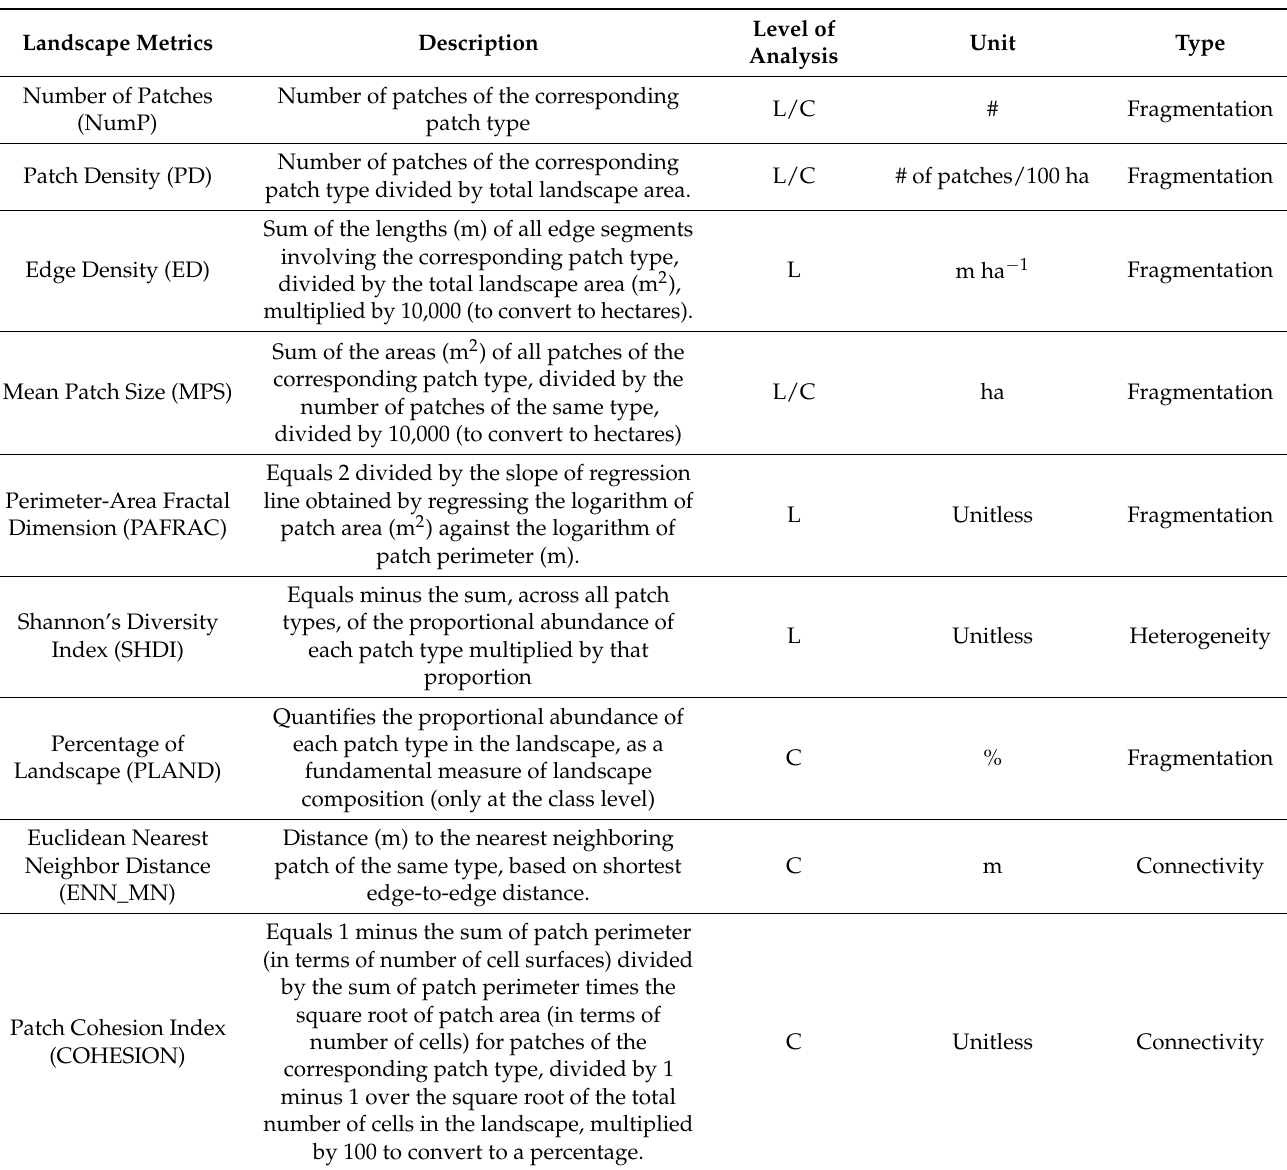
Table 2. Landscape metrics calculated for the land use/land cover of 1990, 2005 and 2017 in a temperate forest of the ‘Sierra Tarahumara’ in Chihuahua, Mexico.